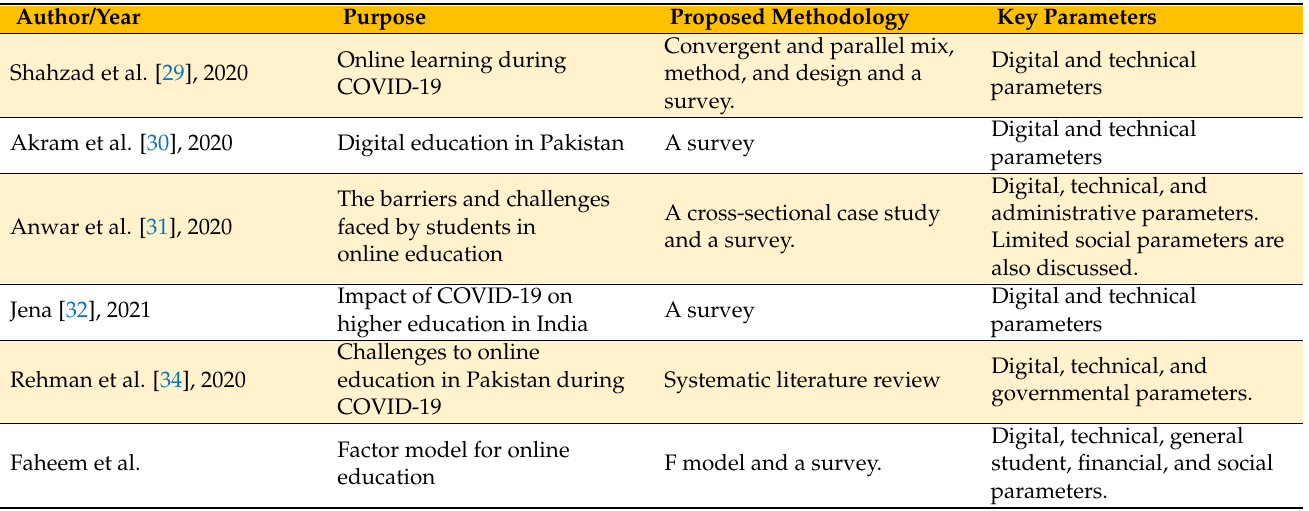
Table 1. Comparison of